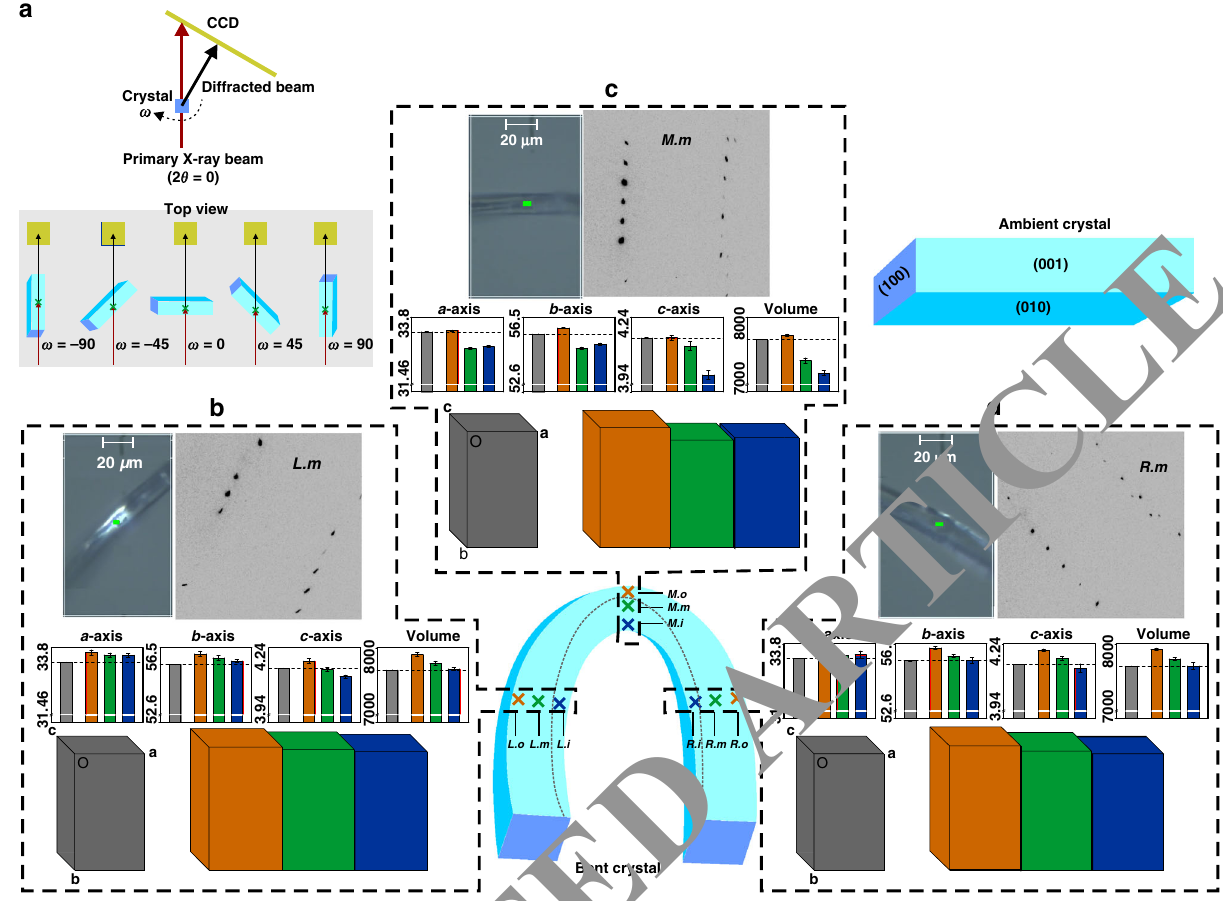
Fig. 3 Spatially resolved μ -SCXRD analysis of mechanically bent crystal. a Schematic representation of the strategy employed in μ -X-ray diffraction data collection. In b , c , and d diffraction peaks, optical images of region of crystal loop, histogram plots of distribution of lattice parameters and boxes representative of schematic unit cells (dark gray = ambient , orange = outer , green = middle and blue = inner ) at the b left shoulder ( L ), c midpoint ( M ), and d right shoulders ( R ). The schematic boxes are drawn while multiplying fi ve times the percentage changes. The neutral axis (an axis in the cross section of the beam along which structural perturbations are minimal) of the bent crystal is outward at M and inward at L and R , and not at the midpoint of the cross section 35 . Absolute error bars are provided in the histogram